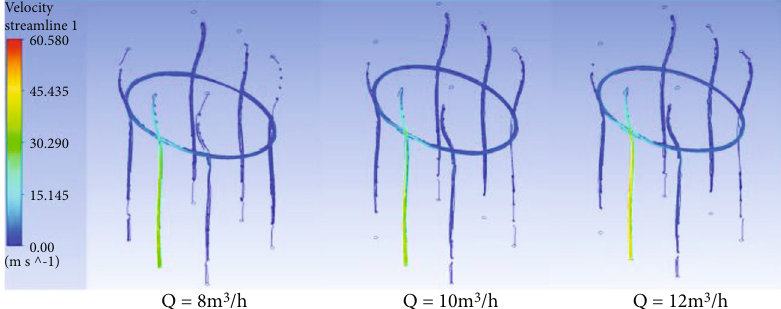
Figure 7: Velocity streamline fi gure of longitudinal type.